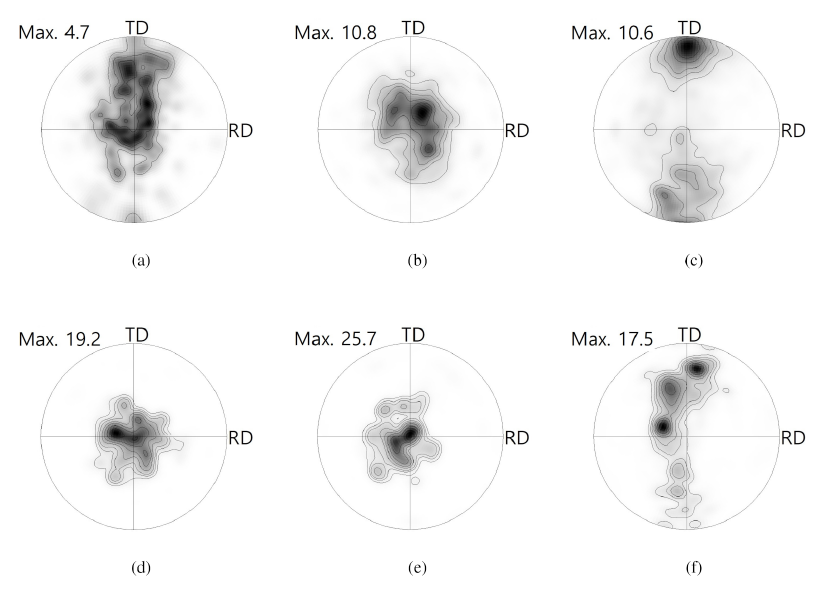
Figure 9. 0001 PFs computed from EBSD maps, as shown in Figure 8. Contours: 1, 2, 3, 5, 7, 10, 15, 20. ( a ) Part 1, ( b ) Part 2, and ( c ) Part 3 for TRC sheets. ( d ) Part 1, ( e ) Part 2, and ( f ) Part 3 for IC